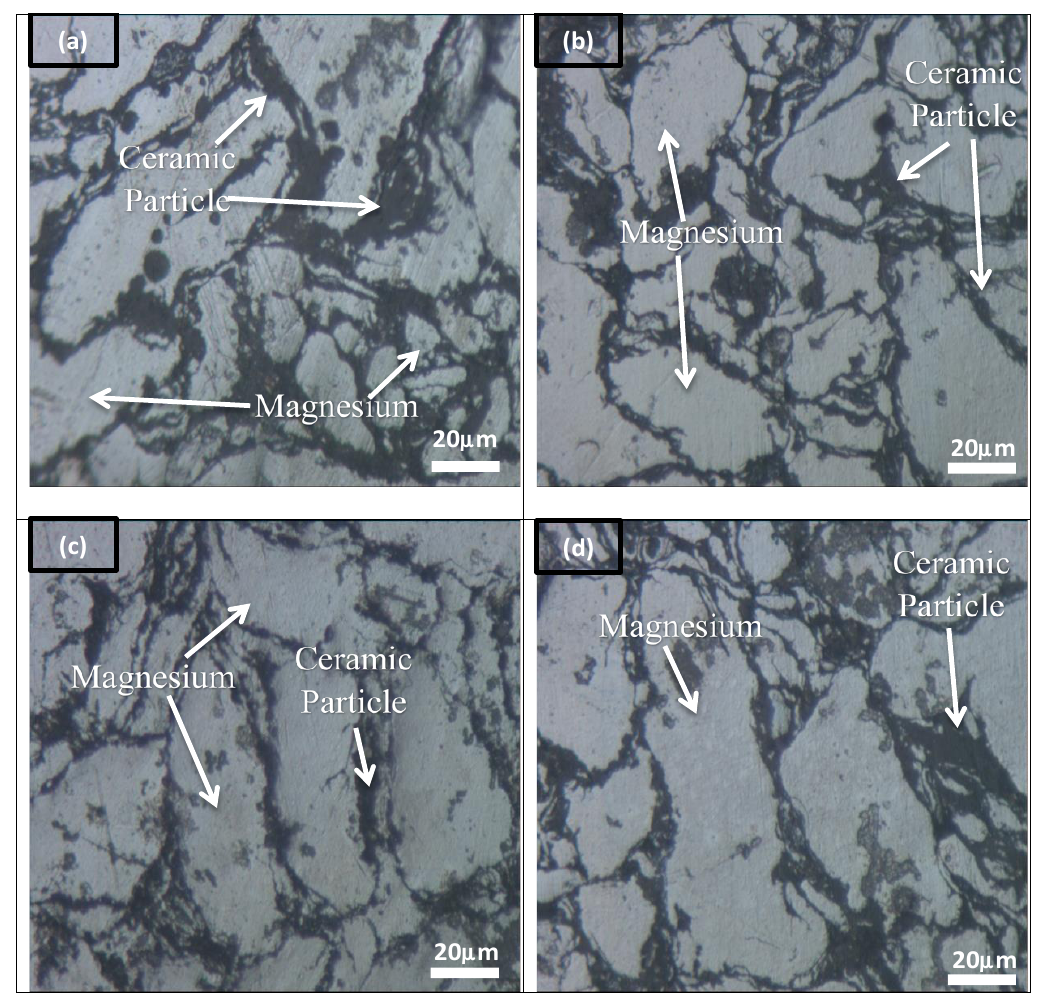
Figure 3. Microstructure of optical micrograph for Mg-Zn/HAP/Al 2 O 3 with ( a ) 0 wt.% ( b ) 5 wt.% ( c ) 10 wt.% and ( d ) 15 wt.% Al 2 O 3 . Table 1. Average grain size for the Mg-Zn/HAP/ Al 2 O 3 composite. Al 2 O 3 Content (wt.%)